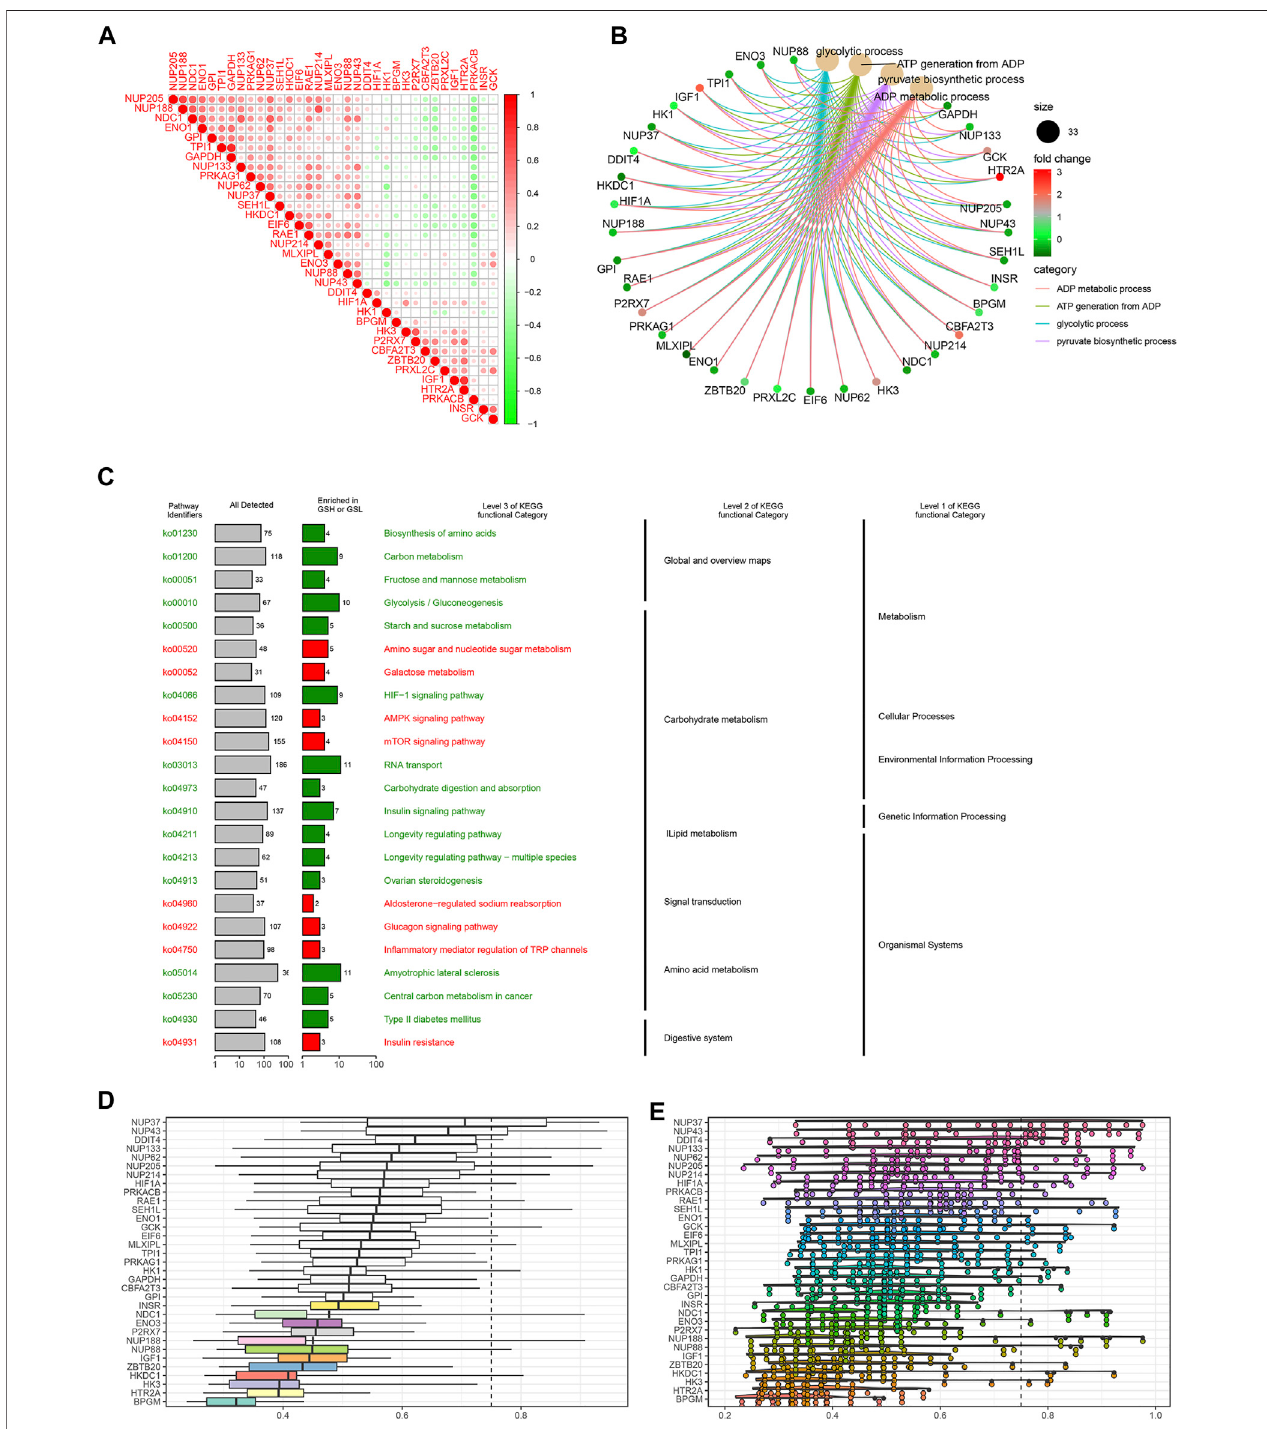
FIGURE 3 | Gene interaction analysis and functional enrichment. (A) Gene interaction network. Red represents positive correlation, while negative correlation is represented ingreen. (B) GO enrichment analysis,including thebiologicalprocess (BP), cellular component(CC), and molecularfunction (MF). Everyterm showstop 10 pathways. (C) Kyoto Encyclopedia of Genes and Genomes (KEGG) pathways enriched in the IGs. IG network analysis. (D) Summary of OGG similarities. The boxes indicated the middle 50% of the similarities, and the upper and lower boundaries show the 75th and 25th percentiles, respectively. (E) Raincloud plots of OGG. Data are expressed as the mean and standard error. Each dot represents the single gene. The dashed line represents the cutoff value (0.75).